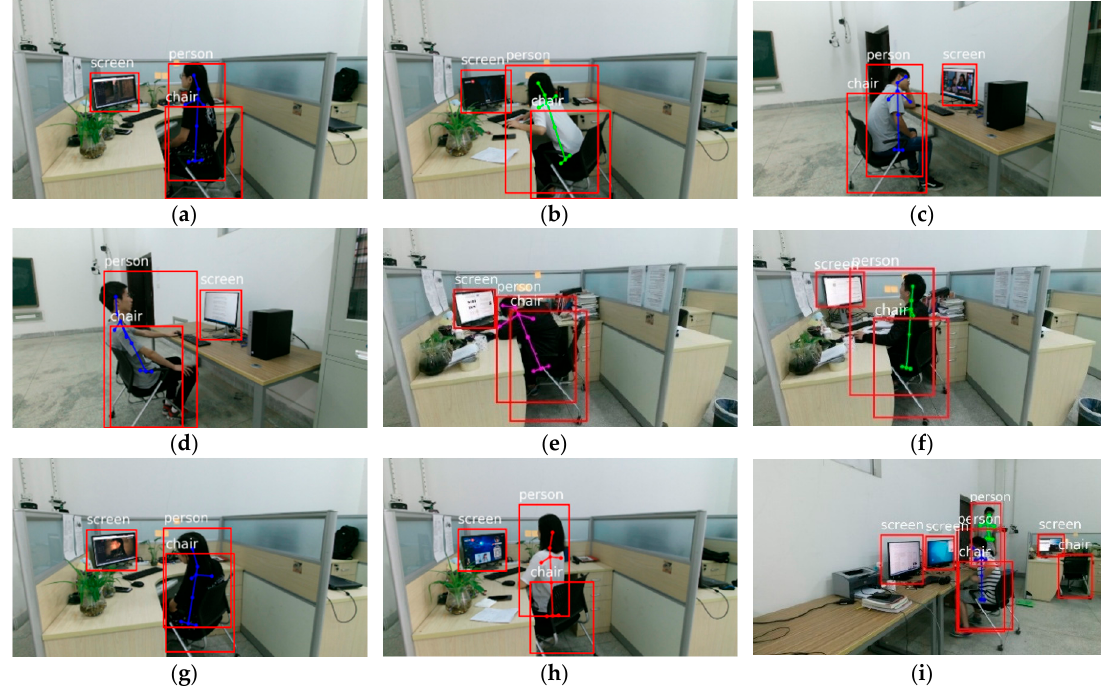
Figure 10. Some detecting results based on self-collected dataset by our proposed method. ( a ) example of healthy sitting posture in screen-reading. ( b – i ) are representative unhealthy sitting postures in screen-reading detected by our proposed method.